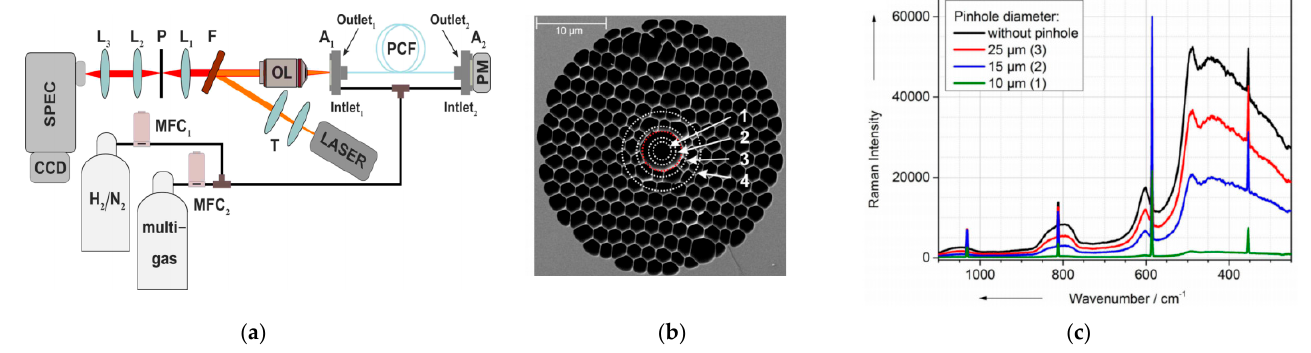
Figure 9. ( a ) Schematic sketch of the experimental setup for HCPBGF. ( b ) Electron microscopic picture of the fiber end face. The circular areas marked by ‘1’, ‘2’, ‘3’, and ‘4’ are the collection areas with pinholes sizes of 10, 15, 25, and 50 μ m in the focal plane. ( c ) Raman spectrum of H 2 and the background silica Raman signal of different fibers. Reprinted with permission from [57]. Copyright (2015) American Chemical Society.